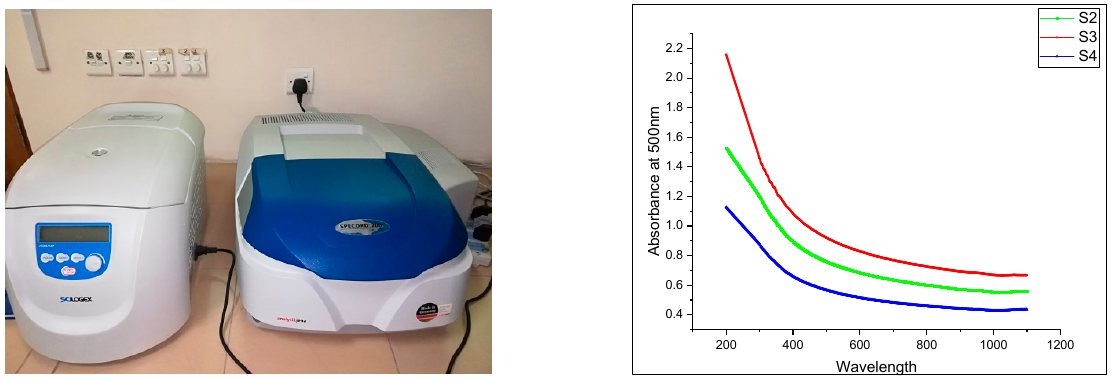
Figure 8. UV-spectroscopy of dispersed nanomaterials.